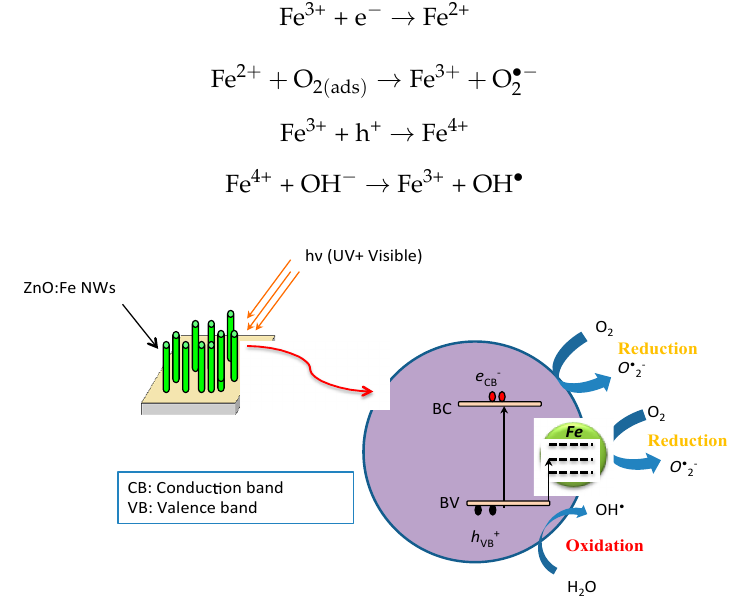
Figure 7. Diagram describing the photocatalytic mechanism of the Fe-doped ZnO NWs.